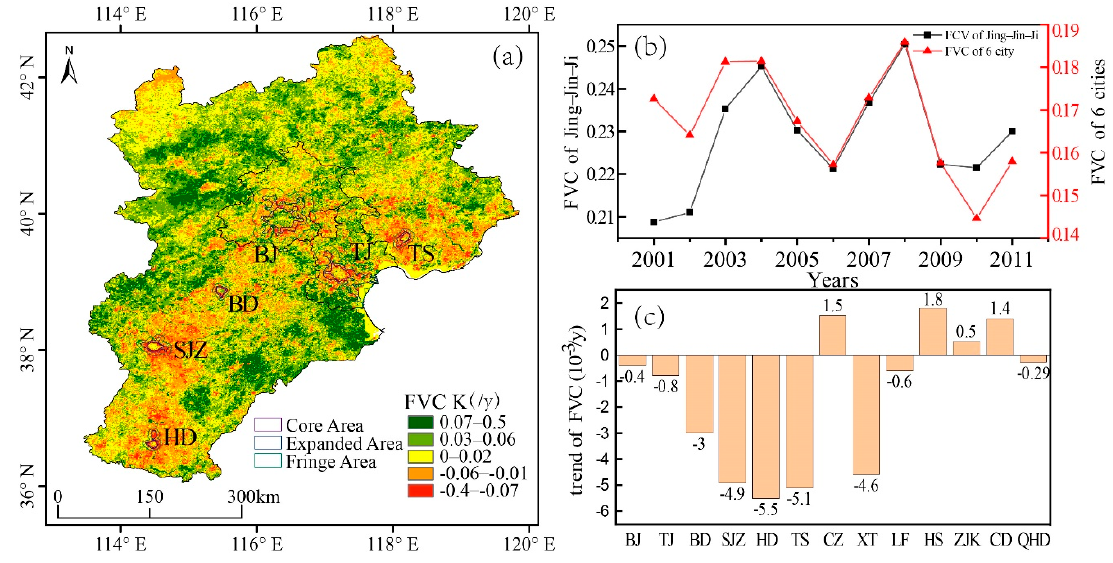
Figure 3. Spatiotemporal variation of the FVC in the BTH region: ( a ) spatial variation of the FVC, ( b ) temporal variation of the FVC, and ( c ) interannual variation rate of the FVC in 13 cities. Beijing (BJ), Tianjin (TJ), Shijiazhuang (SJZ), Handan (HD), Tangshan (TS), Baoding (BD), Zhangjiakou (ZJK), Xingtai (XT), Hengshui (HS), Cangzhou (CZ), Langfang (LF), Chengde (CD), and Qinghuangdao (QHD) refer to 13 cities in the BTH region.